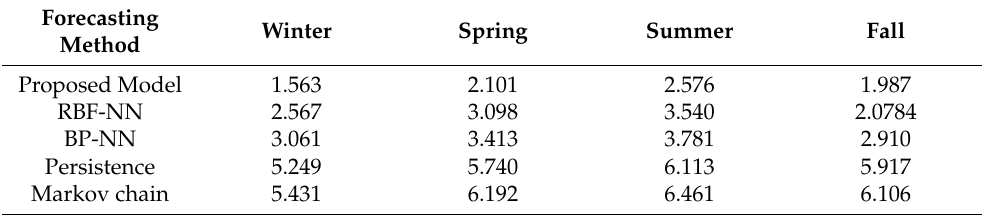
Table 2. Comparison of proposed model for wind prediction with other methods with rest to RMSE. Forecasting Method